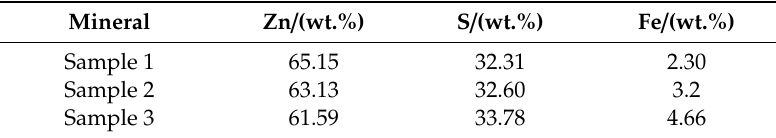
Table 1. Chemical composition of the sphalerite samples. Mineral Zn / (wt.%)